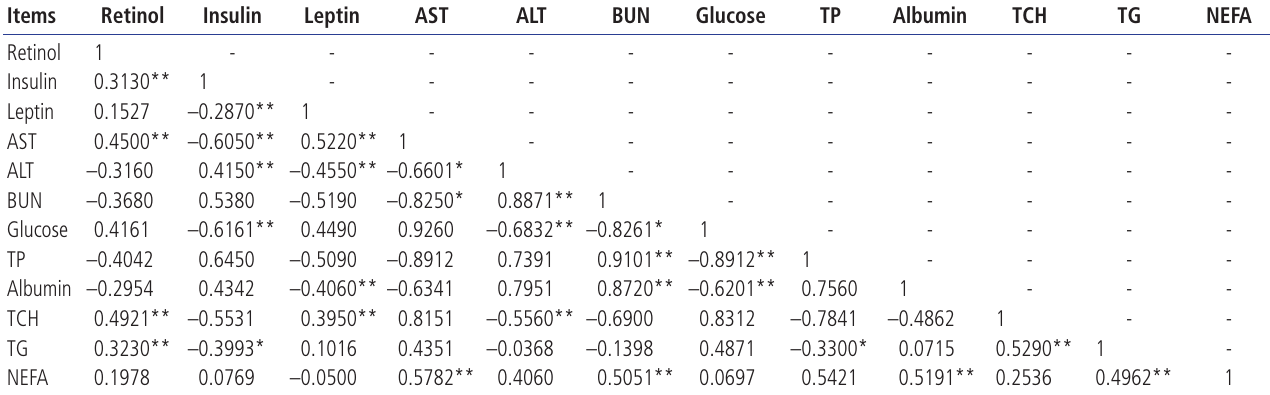
Table 3. The correlation coefficients among blood biochemical components during fattening and finishing phases in Hanwoo steers Items Retinol Insulin Leptin